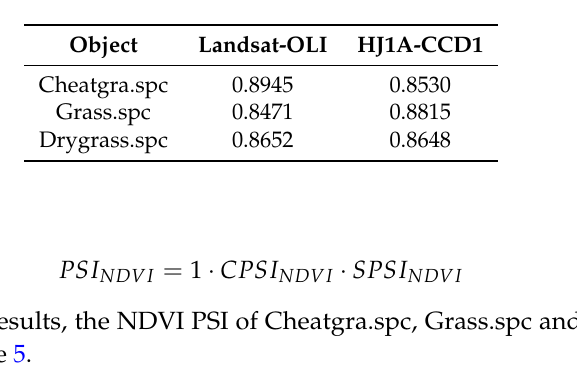
Table 4. The SPSI of Cheatgra.spc, Grass.spc and Drygrass.spc.